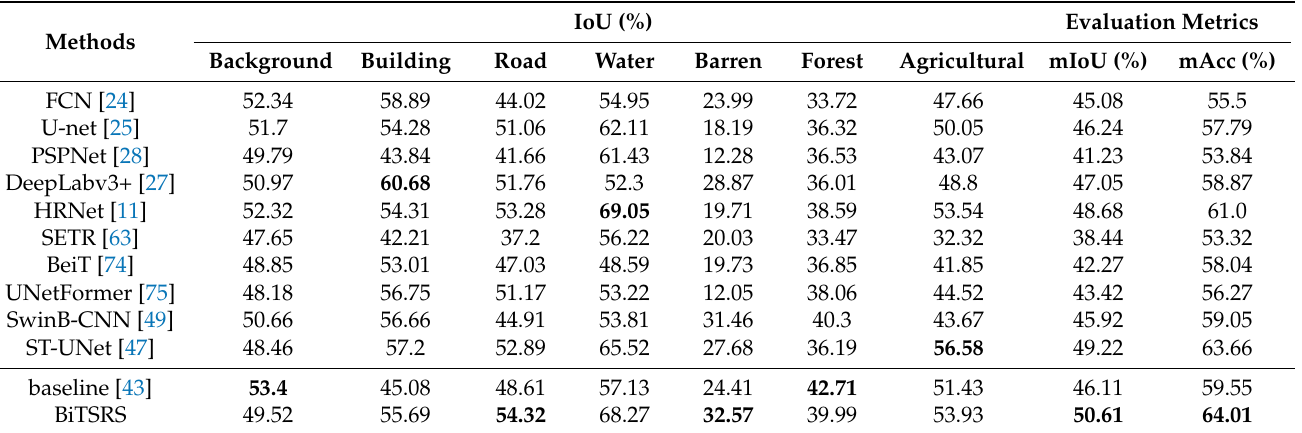
Table 6. Comparison with some state-of-the-art methods on the LoveDA dataset. The maximum value of each column is shown in